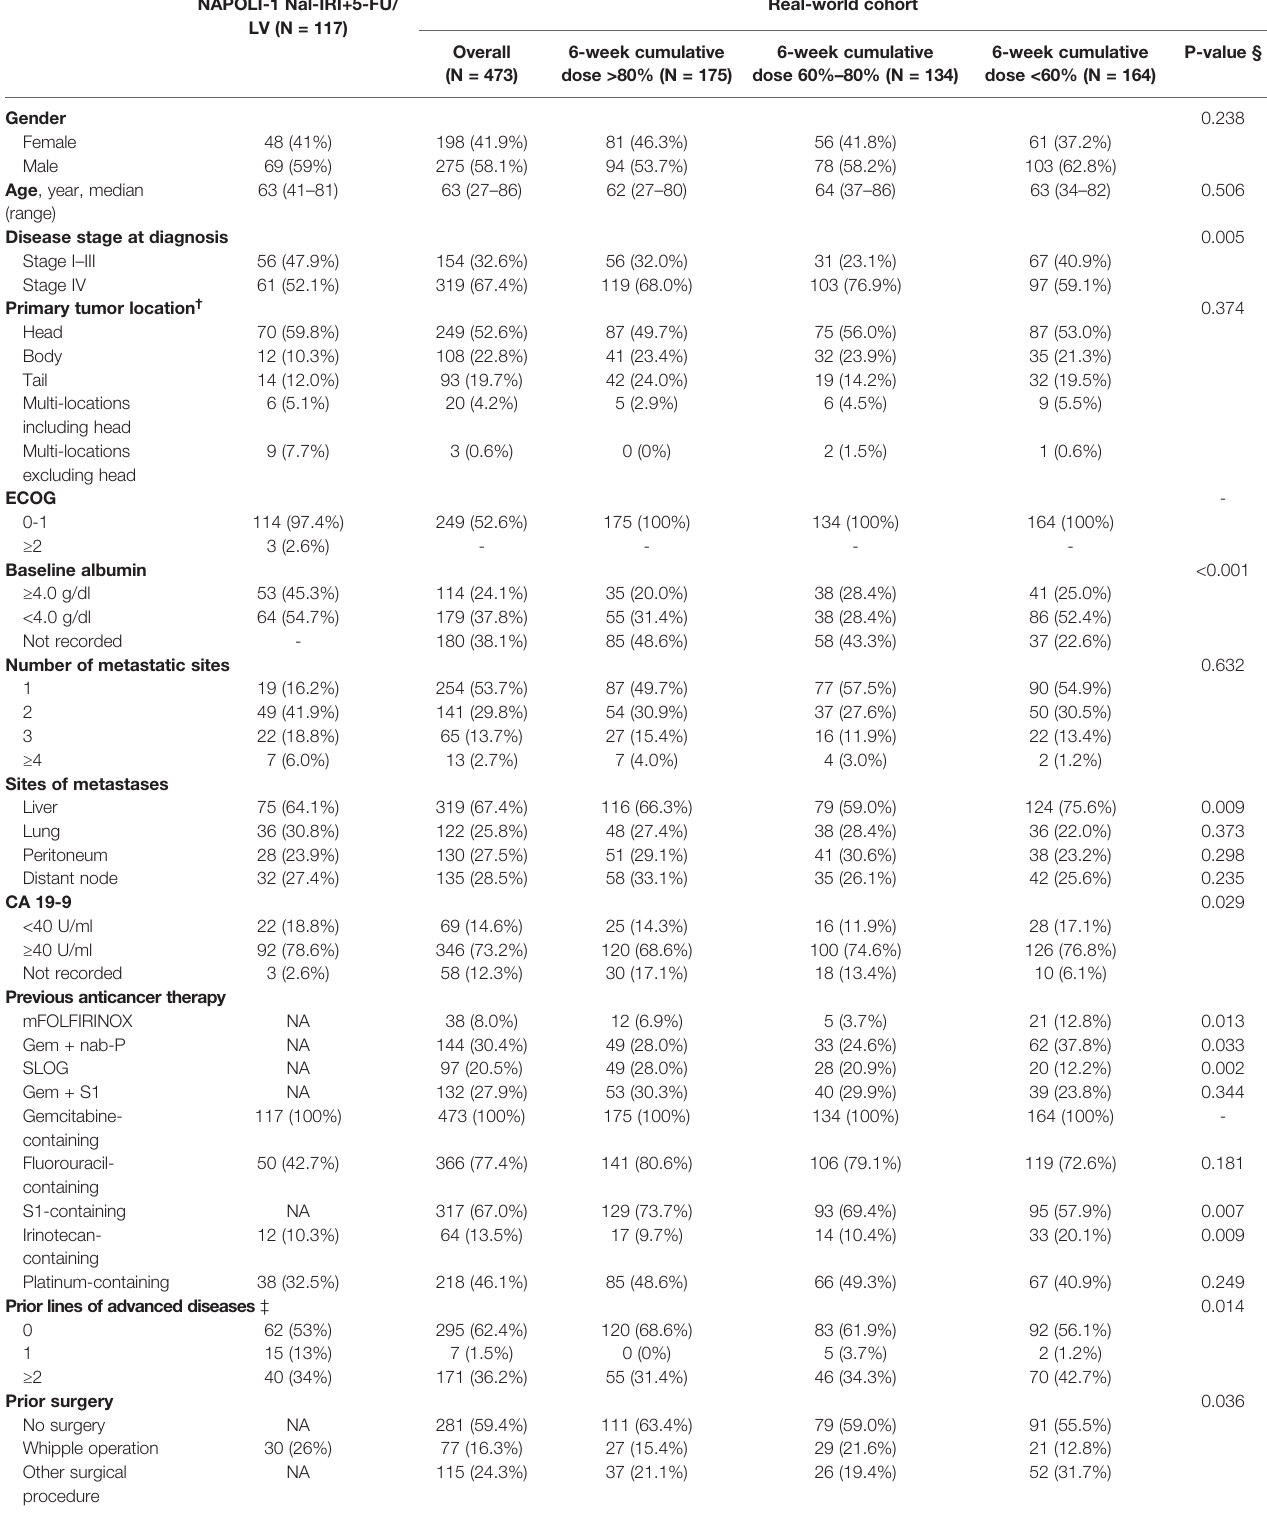
TABLE 1 | Baseline